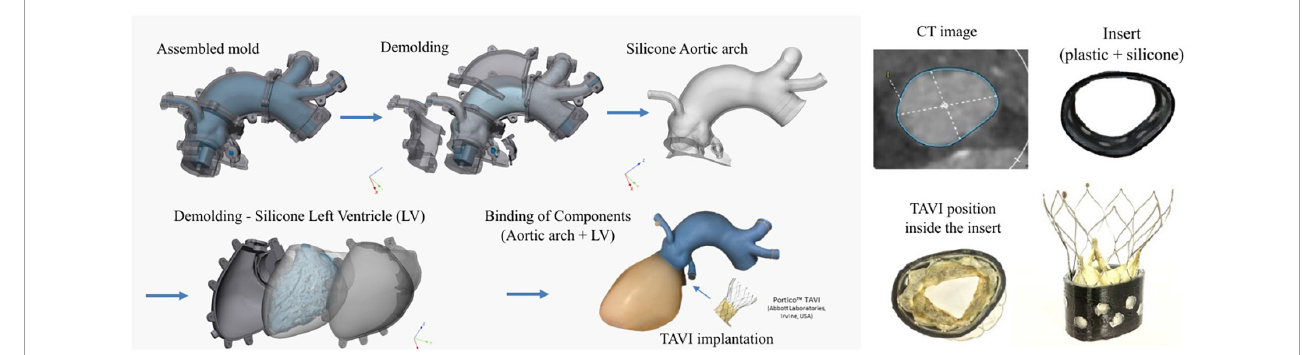
FIGURE1 Three-dimensional representation of the phantom and molding process steps (left) and details of the CT image of the aortic annulus and fabrication of two layer insert with the transcatheter aortic valve implantation (TAVI) positioned within the insert (right) .